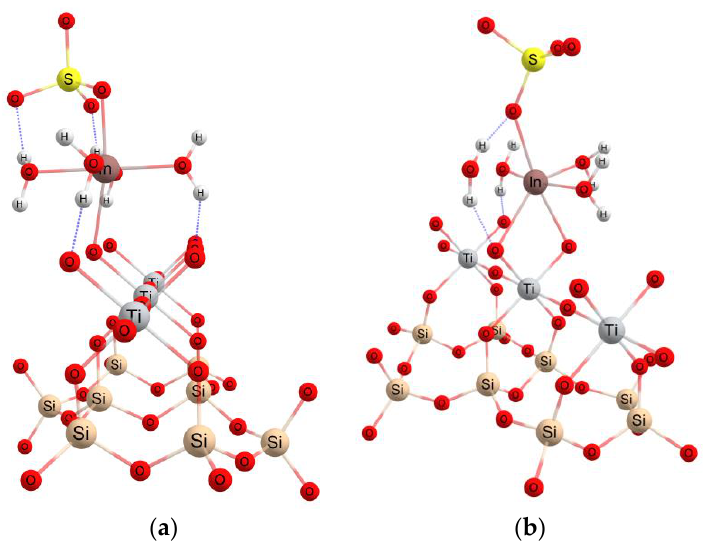
Figure 8. The interaction with the ETS-10 adsorbent surface and the formation of one ( a ) or two ( b ) bonds with oxygen.